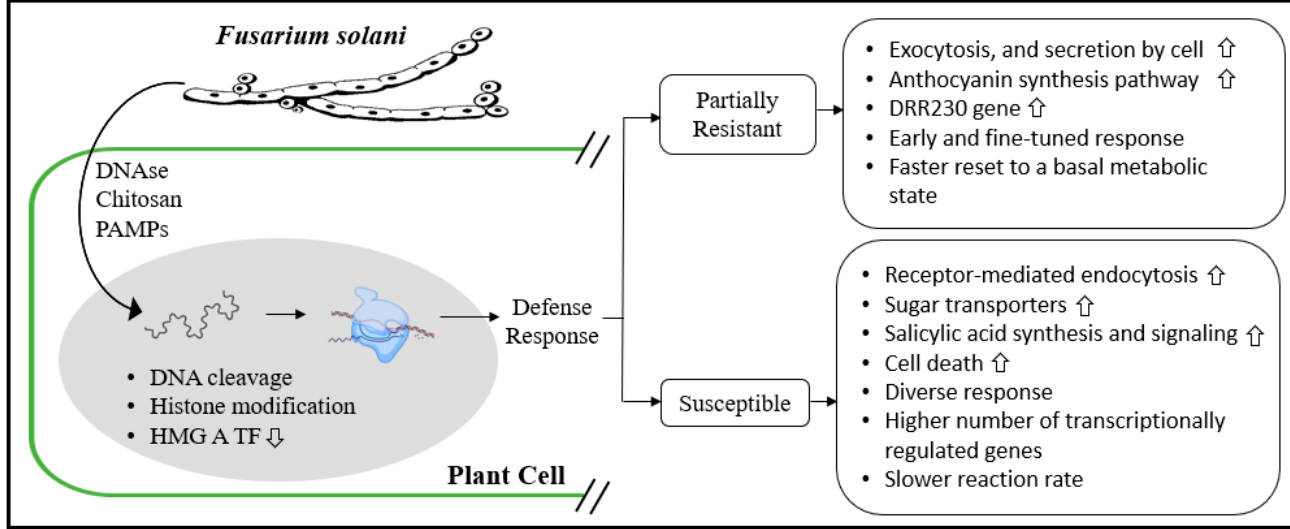
Figure 2. A model representing reported changes detected following Fusarium solani f. sp. pisi ( Fsp ) inoculation in pea. Events include the action of Fsp DNAse, chitosan, and PAMPs and/or their detection by the host. DNase and chitosan are associated with nuclear fragmentation in the plant nucleus affecting chromatin structure. These changes, along with the host’s detection of PAMPs, trigger defense responses such as the accumulation of pathogenesis-related (PR) genes. Specific responses in partially resistant and susceptible pea genotypes are depicted. Upwards and downwards pointing arrows represent overexpression and underexpression of genes, respectively. Model developed from the results presented in Hadwiger, (2008); B. A. Williamson-Benavides et al., (2020) [304,308].